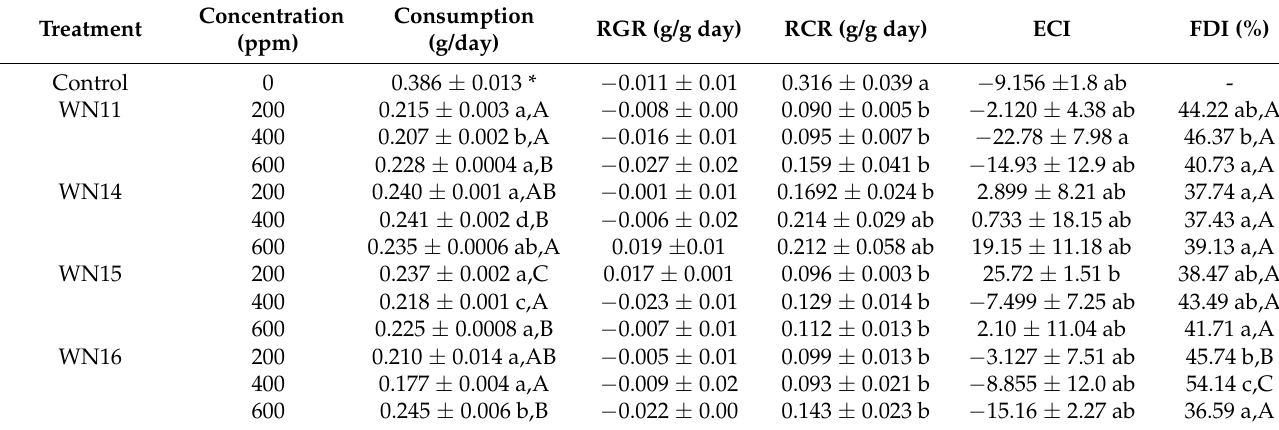
Table 2. Mean ± SE of data for RPW larvae that were treated with eugenol